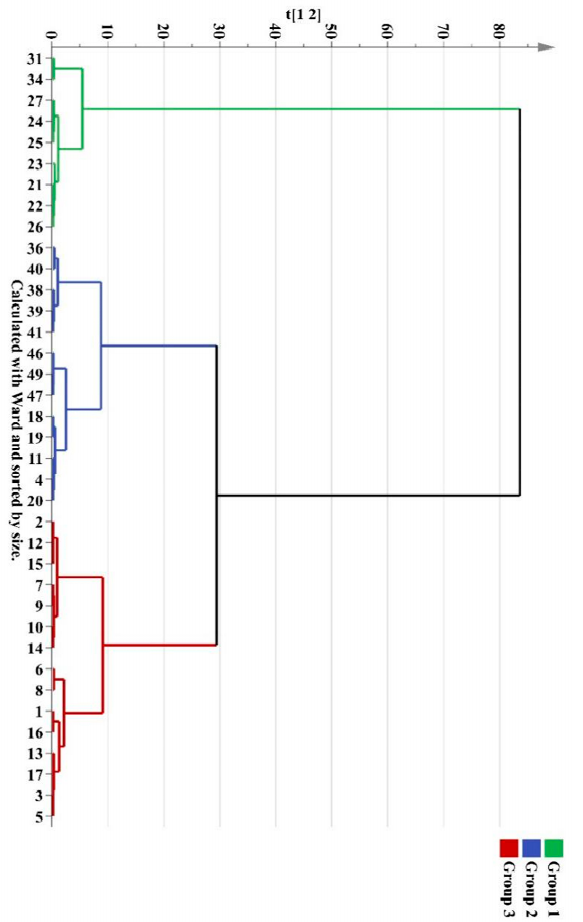
Figure 3. HCA dendrogram of different M. bealei samples and its substitutes.